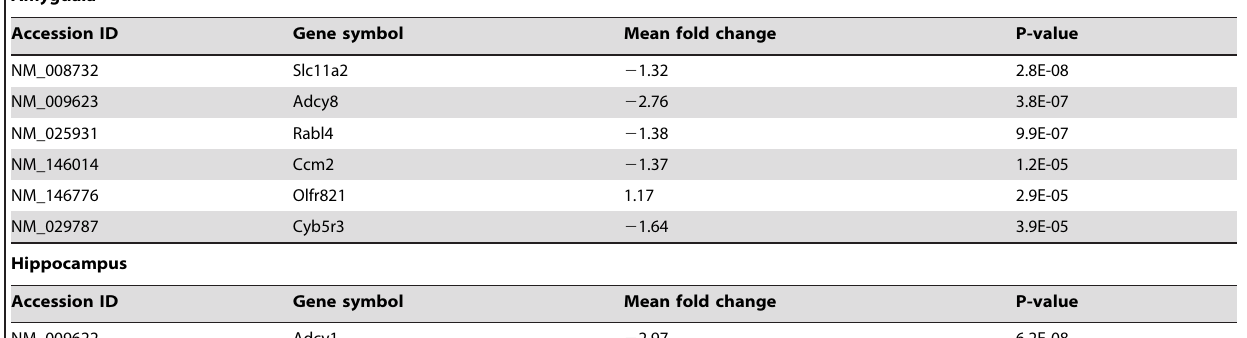
Table 1. Genes that are modulated during development.